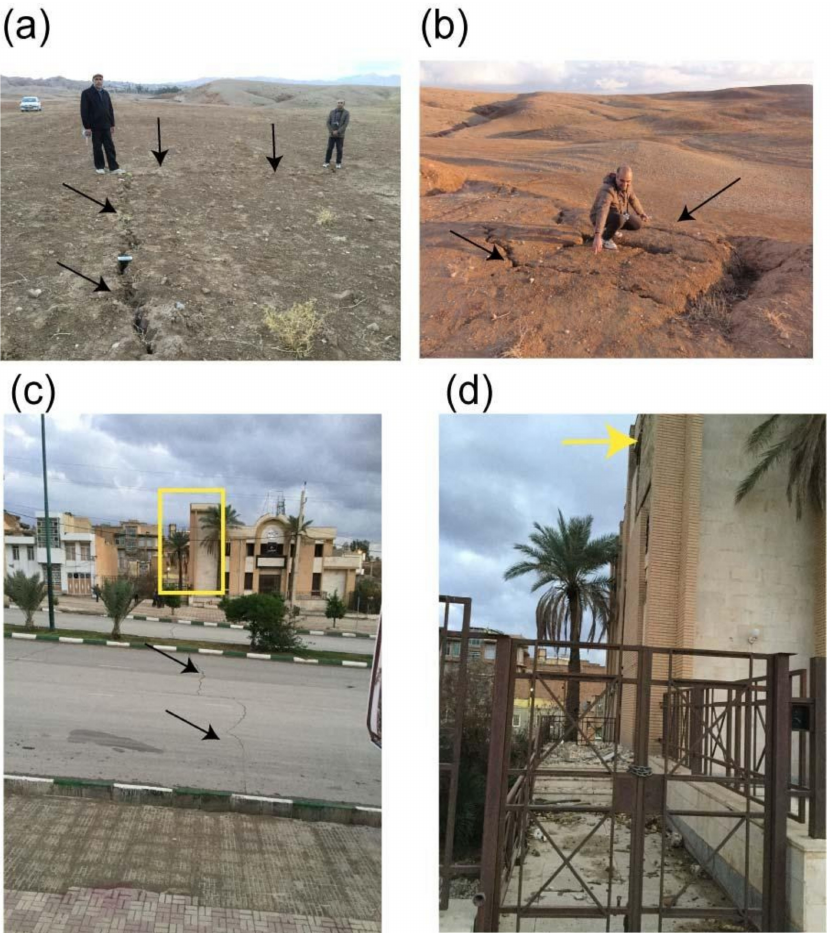
Figure 13. ( a , b ) Ground photos of en echelon cracks developed at P5 in Figure 9. ( c ) Some cracks in Qasr-e Shirin City developed along the fault (white line passing through P5 in Figure 9) that was activated in the 2017 earthquake. ( d ) Close-up photo of area marked by the yellow rectangle in Figure 13c. The yellow arrow marks the region of fallen bricks at the building damaged by the earthquake.